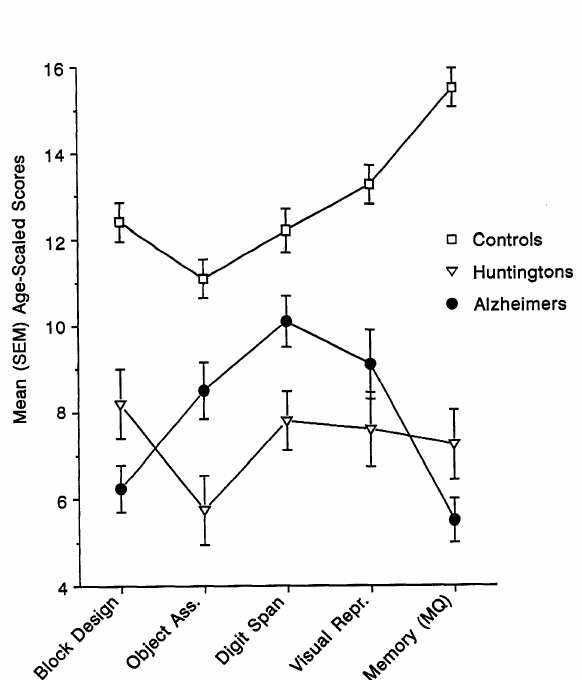
FIG. 1. Discrimination patterns of those variables identified as maximally separating Alzheimer's, Huntington's and control subjects.